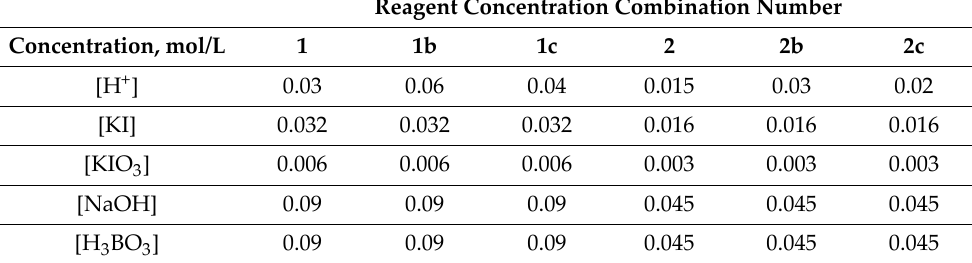
Table 1. Combinations of reagent concentrations for the experimental determination of the micromix‑ ing quality in microreactors recommended in